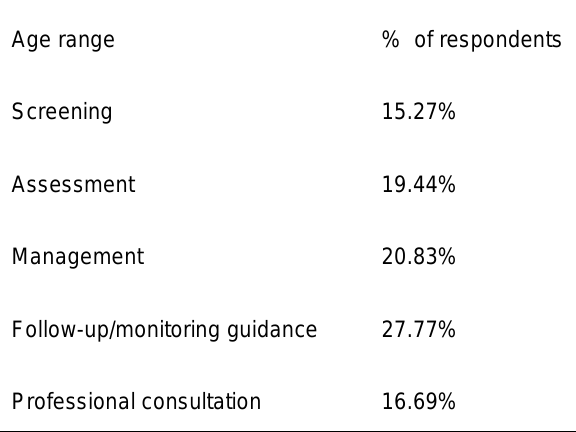
Table 1. Age Range Served By Telepractice Service Table 2. Services Delivered Through